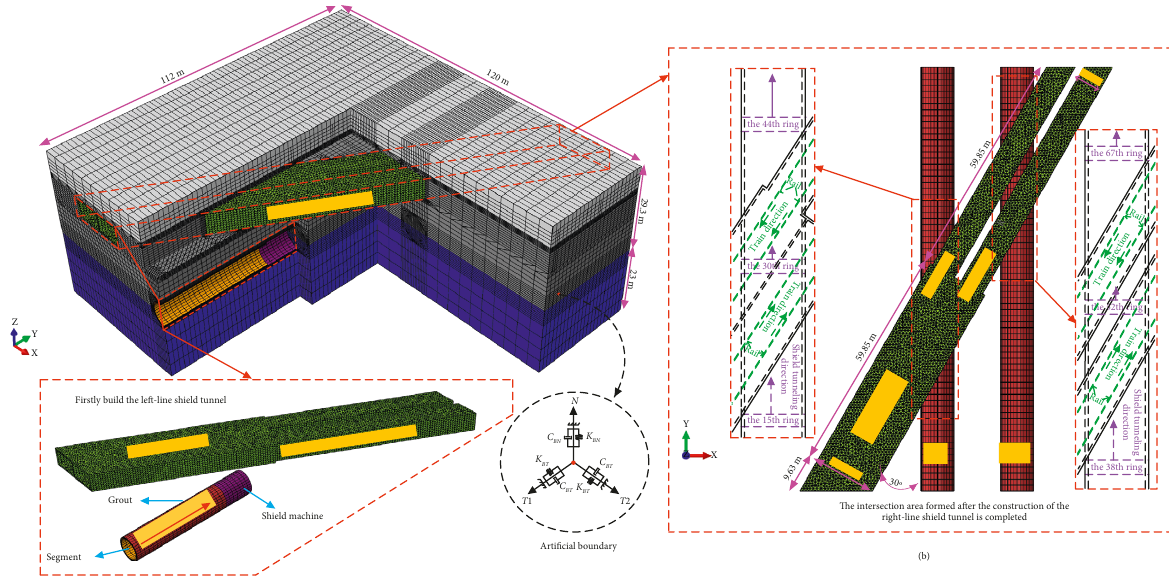
Figure 5: 3D finite element numerical model: (a) location relationship between the left-line shield tunnel and metro line 3 tunnel; (b) labeling of specific detailed construction steps for shield tunneling through intersection